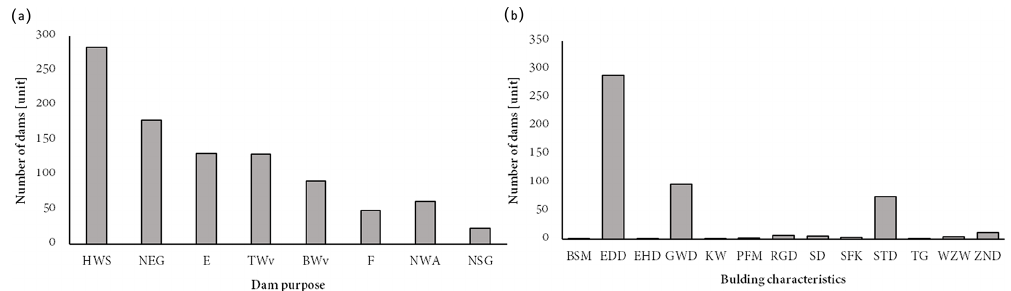
Figure 3. Dam purpose (a) and building characteristics (b) . Purposes are abbreviated as BWv (industrial agricultural water supply), E (energy production), F (fishing), HWS (flood control), NEG (recreational), NSG (nature protection), NWA (transport), and TWv (water supply). Building characteristics are abbreviated as BSM (arch dam), EDD (embankment dam), EHD (homogenous rockfill dam), GWD (gravity dam), KW (flap weir), PFM (buttress dam), RGD (ring dam), SD (fill dam), SFK (segment with fish belly flap), STD (rockfill dam), TG (residual lake associated with mining), WZW (rolling weir), and ZND (zone